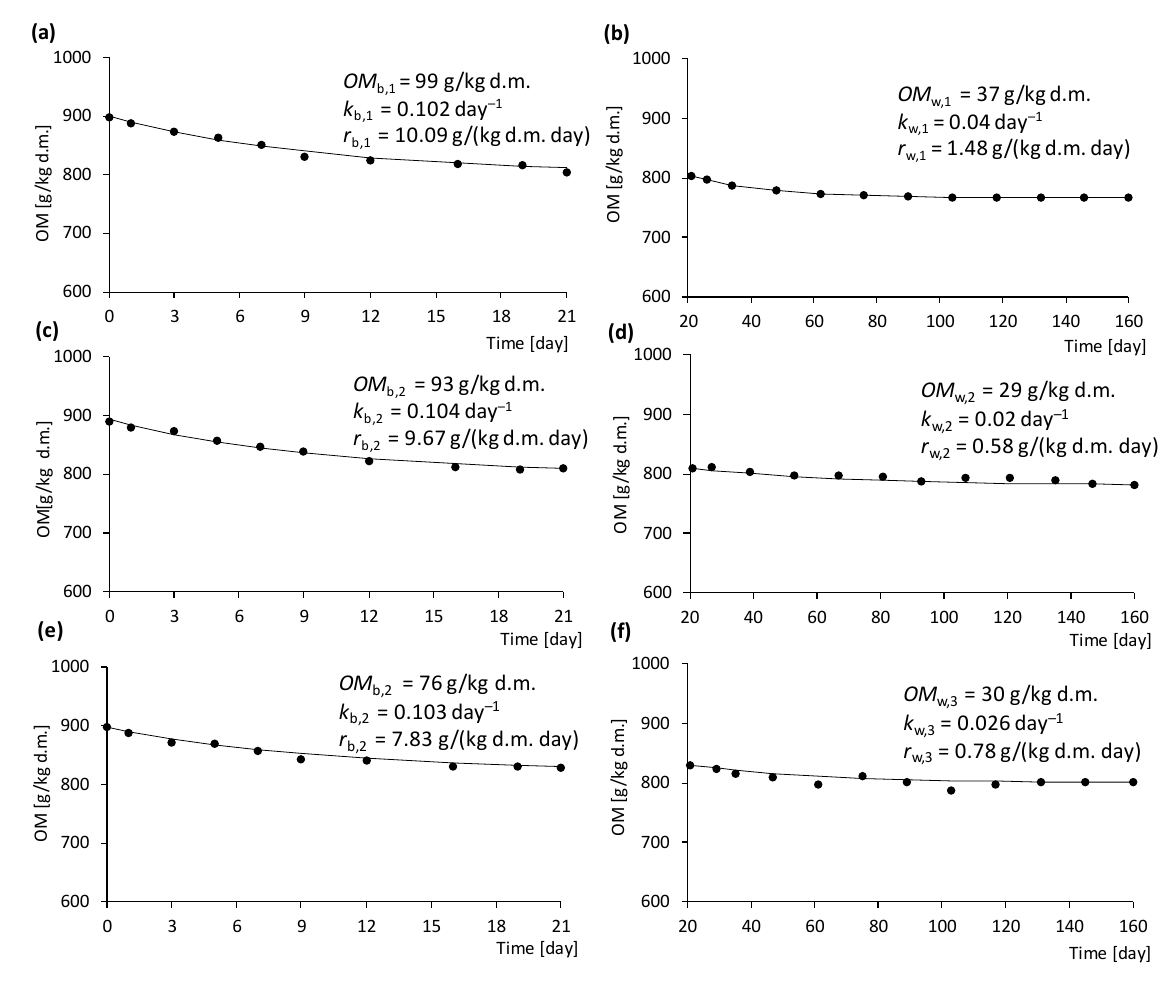
Figure 2. Changes in the organic matter (OM) content during composting (until the 21st day in the bioreactor, and then in the windrow) of FC 1 ( a , b ), FC 2 , ( c , d ), and FC 3 ( e , f ) in the bioreactor ( a , c , e ) and the windrow ( b , d , f ); kinetic parameters are given, in terms of the maximal OM removal during the composting process (A b —in the bioreactor, A w —in the windrow), the rate constant of OM removal (k b —in the bioreactor, k w —in the windrow), and the rate of OM removal (r b —in the bioreactor, r w —in the windrow).